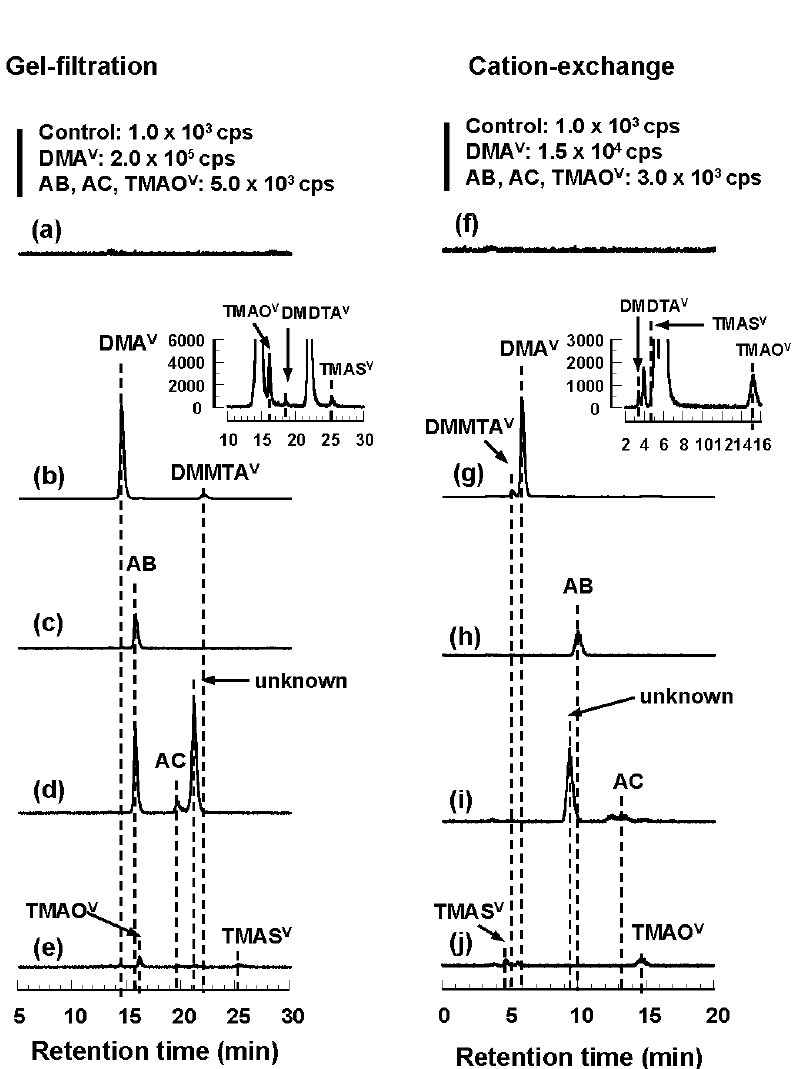
Figure 6. Elution profiles of extract of 0–24 ‐ h feces in rats after oral administration of: ( a , f ) deionized ‐ distilled water (control); ( b , g ) DMAV; ( c , h ) AB; ( d , j ) AC; or ( e , j ) TMAOV. Samples were separated by ( a – e ) gel filtration or ( f – j ) cation ‐ exchange and assayed by HPLC ‐ ICP ‐ MS. A 20 ‐μ L sample was applied to the columns, which were eluted with the pre ‐ filtered (0.22 μ m) mobile phase (see Table 1 for the elution conditions). The vertical bars indicate the level of detection (counts per second) for the main panels; separate scales (in cps) are provided for the insets.